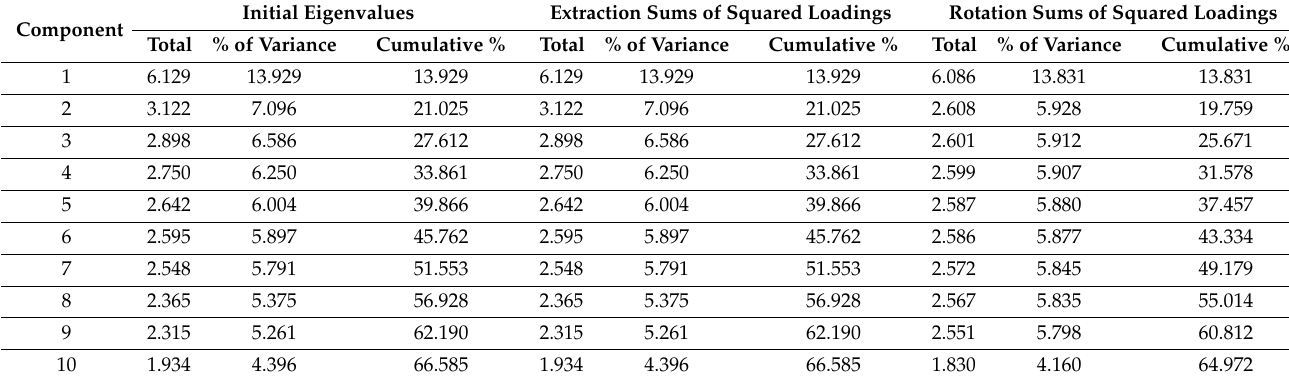
Table 5. Total Variance